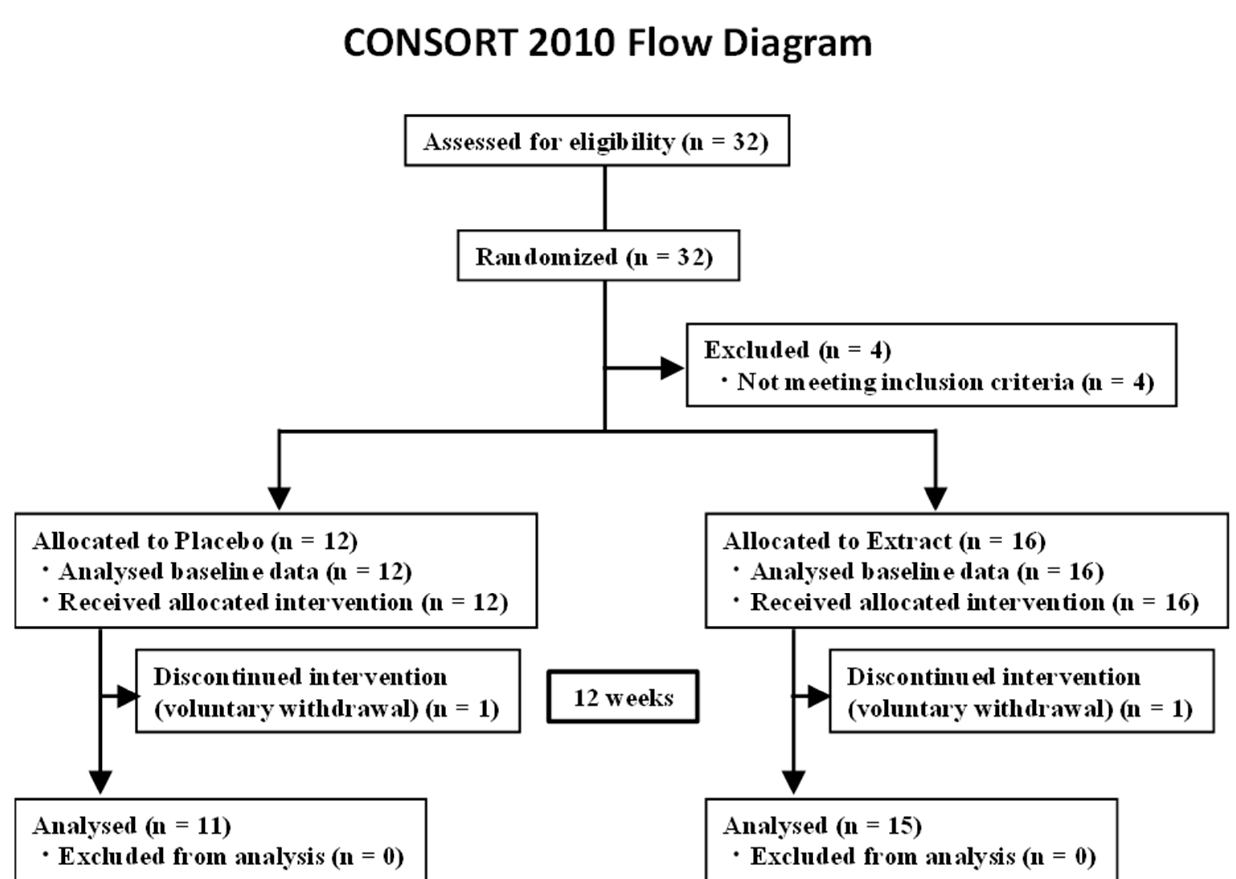
Figure 1. Study flow (CONSORT 2010 diagram). CONSORT, Consolidated Standards of Reporting Trials.